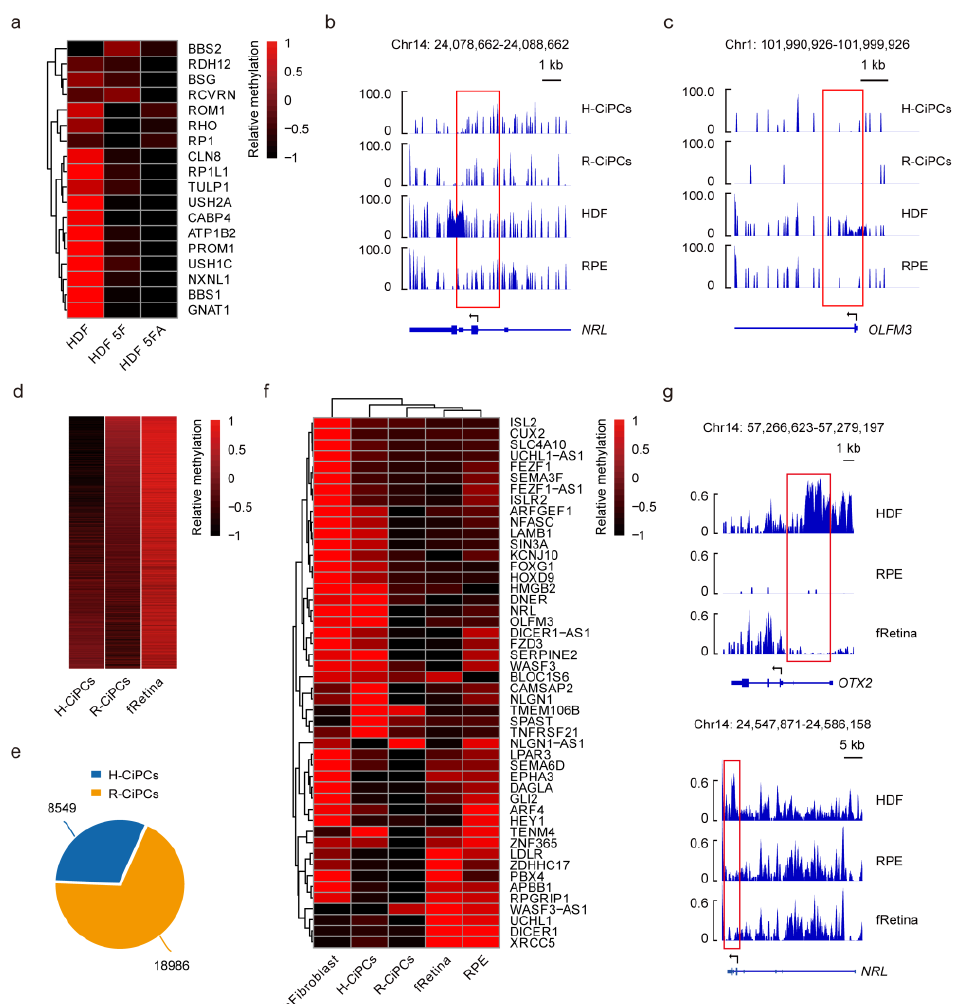
Figure 8. The retinal-like epigenetic modification enables RPE cells to perform better in photoreceptor induction. ( a ) Heatmap showing the differently methylated genes with the treatment of 5F or 5FA on HDF at D10. ( b , c ) Example of a genome browser view of DNA methylation profiles of NRL ( b ) and OLFM3 ( c ) in HDF-derived samples and RPE-derived samples. Each track shows the percent methylation of individual CpGs. ( d ) Heatmap showing the differently methylated genes in H-CiPCs, R-CiPCs, and fRetina. ( e ) Pie plot showing the distribution of methylation changes in H-CiPCs and R-CiPCs at gene promoters upon 5F treatment. ( f ) Heatmap showing the differently methylated genes associated with neurogenesis in H-CiPCs and R-CiPCs. ( g ) Example of a genome browser view of DNA methylation profiles of OTX2 and NRL gene in HDF, RPE, and fRetina. Each track shows the percent methylation of individual